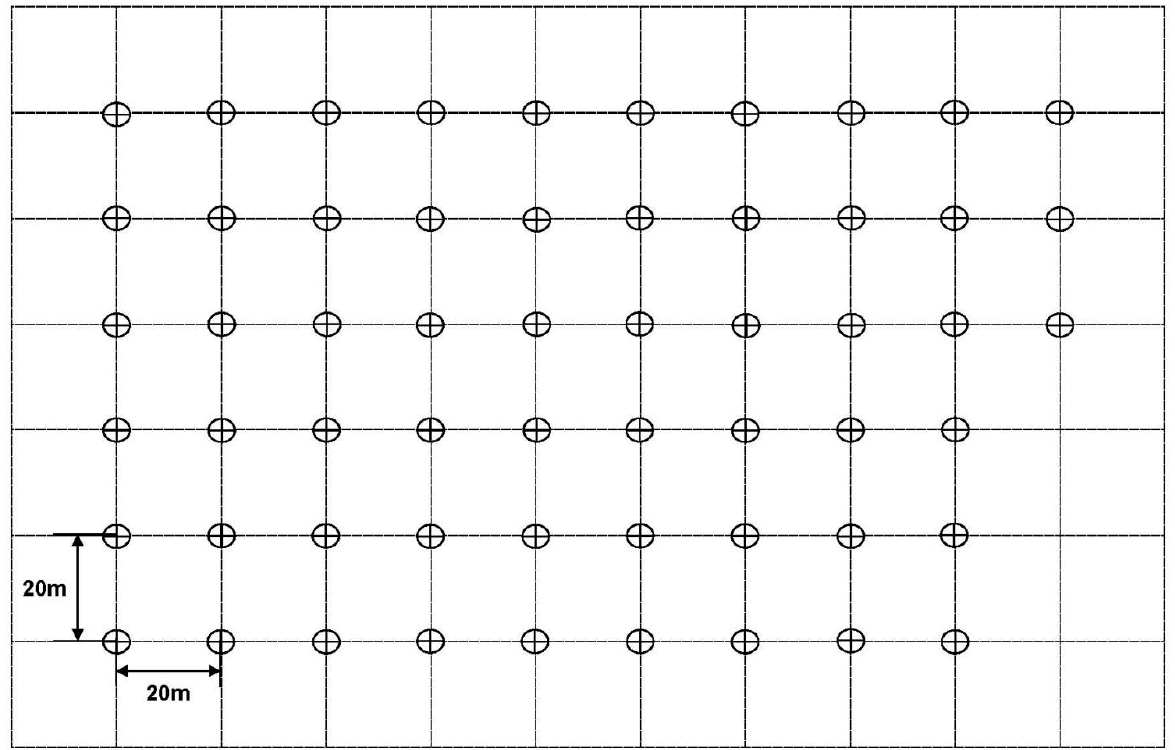
Figure 1. Space layout of 57 LED-equipped traps at 19 single wavelengths in the field. Each circle in the picture represents a